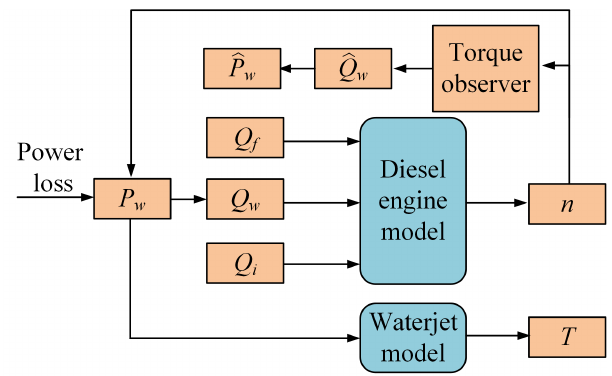
Figure 3. Waterjet load torque estimation